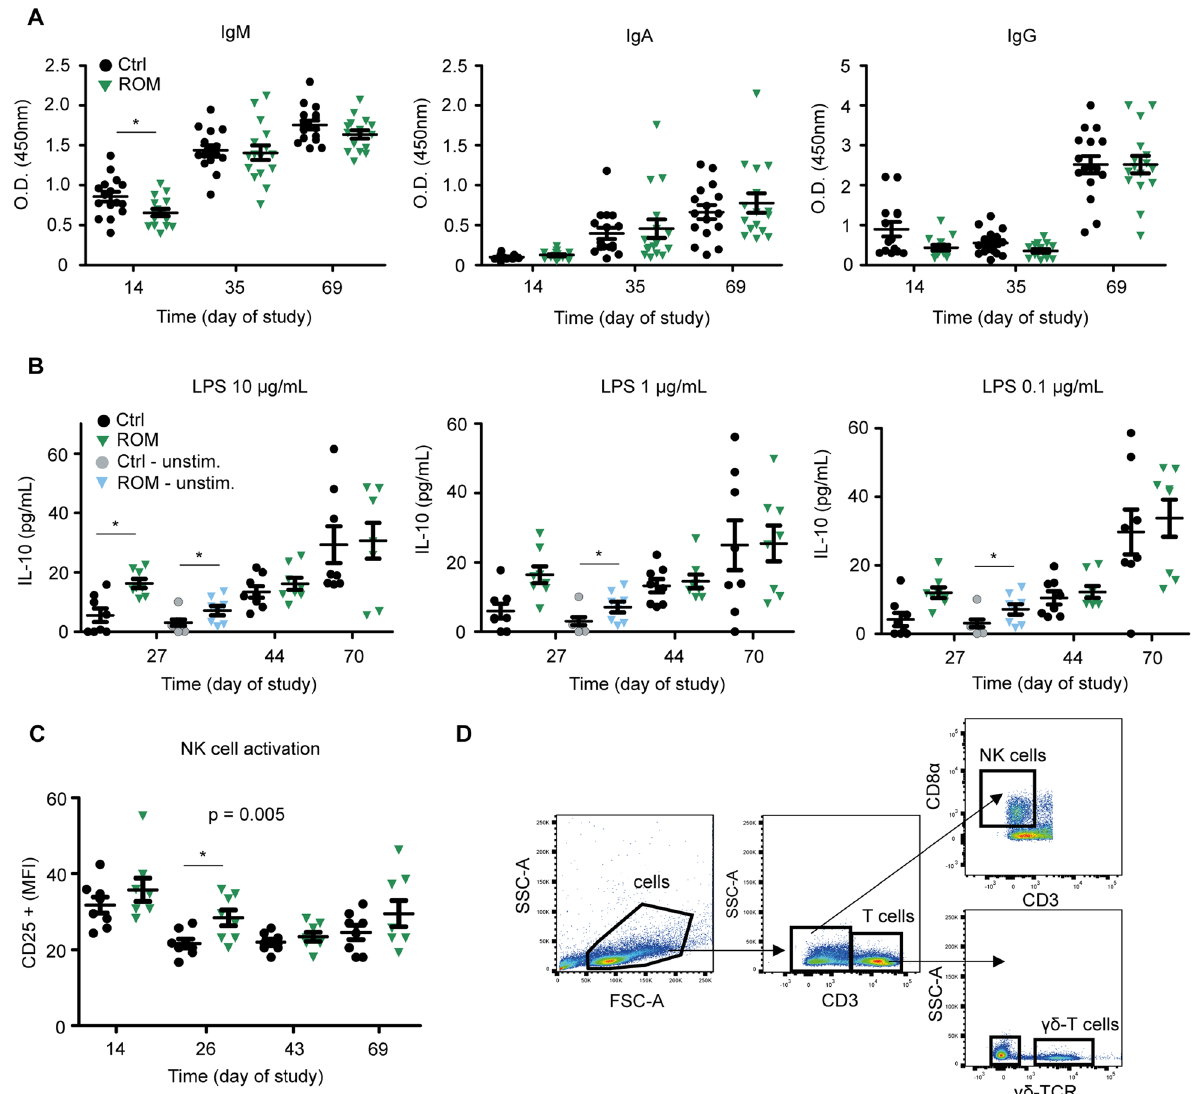
Fig. 8 Immunological analysis. A Serum levels of Salmonella ‑specific IgM, IgA, and IgG prior to vaccination (day 14), 2 weeks after the initial vaccination (day 35), and 3 weeks after the booster vaccination (day 69). B IL‑10 production upon ex vivo stimulation of MLN cells. MLN cells were stimulated for 24 h with 10, 1, and 0.1 μg/mL of LPS, or left unstimulated (cell culture medium only). C Activation of Natural Killer cells in PBMCs. D Gating strategy to identify Natural Killer cells. p values indicate significant differences between treatment groups over time, and asterisks are used to indicate significant differences between treatment groups after taking into account single time points (* p < 0.05). Every point represents an individual animal from a separate pen (n 7 or 8 per treatment group), and error bars represent standard deviations. Normal distribution and equal = variances of data were checked and log‑transformed when necessary. No differences in IL‑10 production by unstimulated MLN cells were